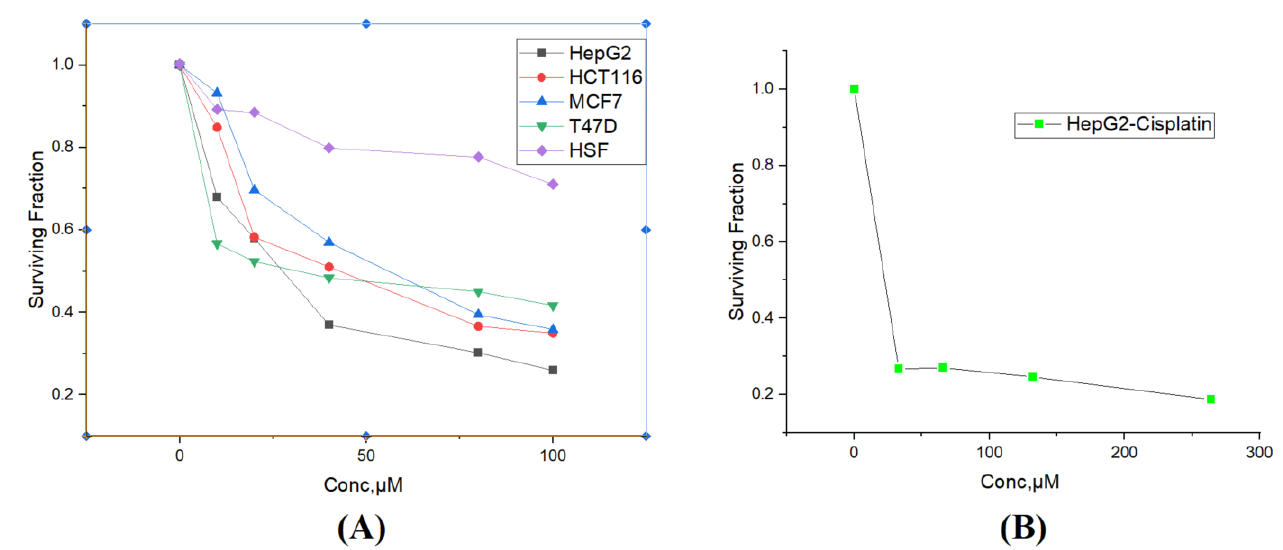
Figure 3. ( A ) The effect of the RuL complex on the proliferation of the tested cell lines; ( B ) the effect of cisplatin toward the proliferation of HepG2. Data are presented as the means of triplicate measurements from three independent experiments.